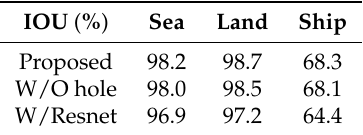
Table 5. IOUs of the proposed method/without hole/with